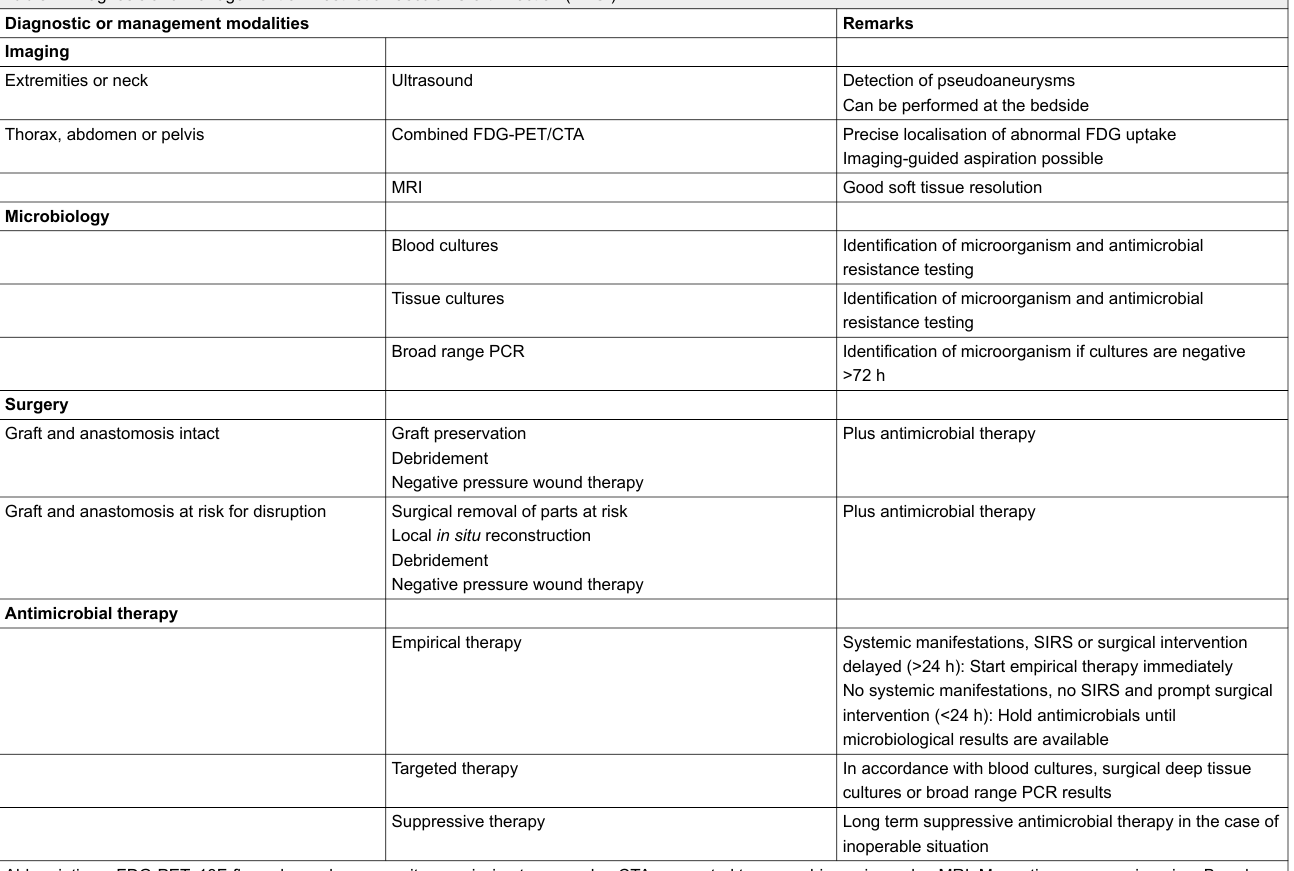
Table 2: Diagnosis and management of Prosthetic Vascular Graft Infection (PVGI). Diagnostic or management